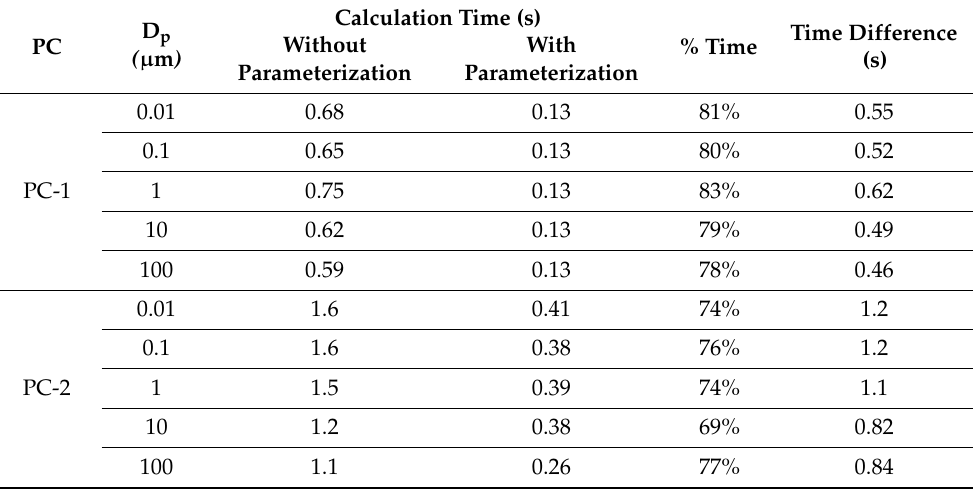
Table 4. A comparison between calculation time for unoptimized code (without parameterization) and optimized one (with parameterization) for four computers for a selected particle diameters ( D p ) for friction velocity u* = 1